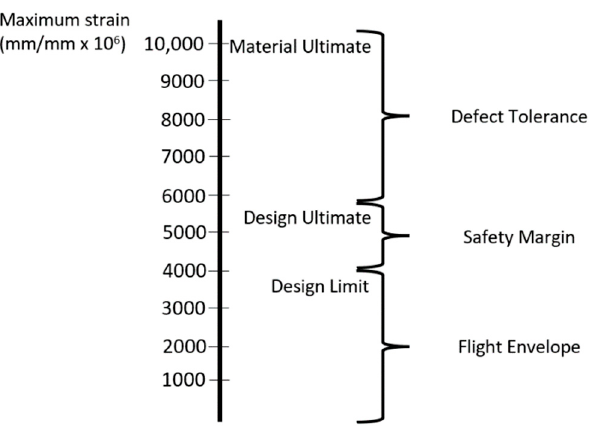
Figure 34. Typical design allowables for carbon fibres reinforced plastics (CFRP).